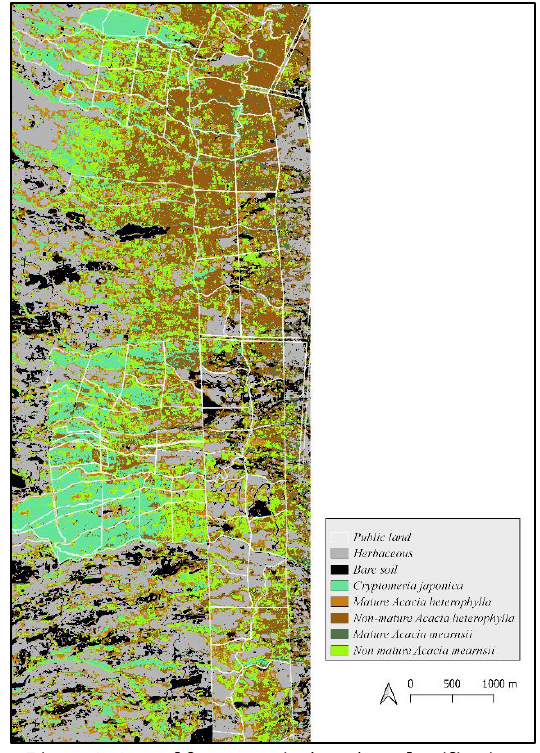
Figure 4. Map of forest species based on classification results, Western Highlands region, Reunion Island.